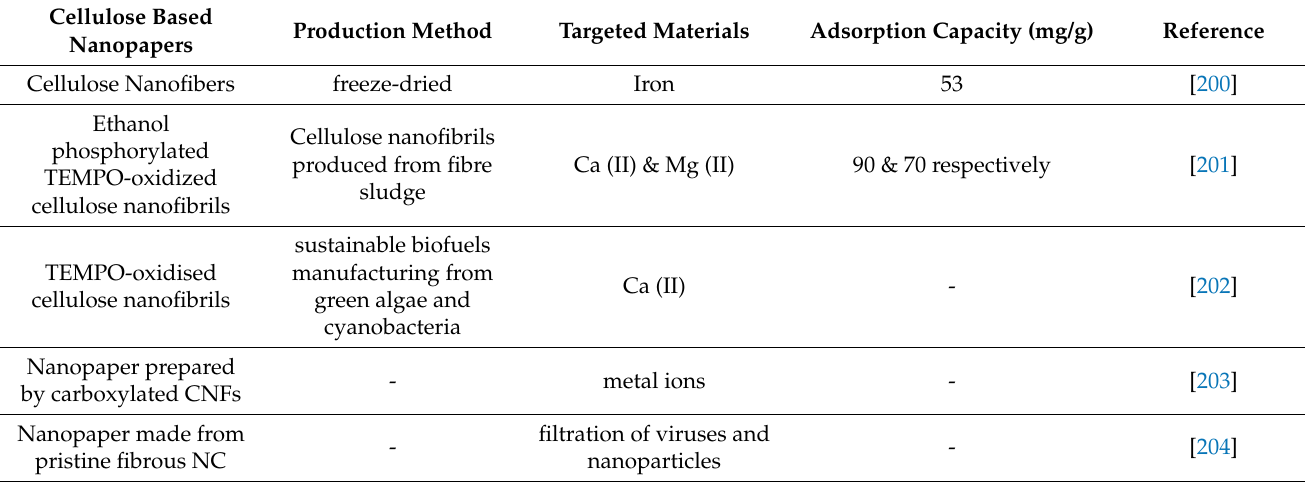
Table 6. Manufacturing Methods for Cellulose Nanopaper